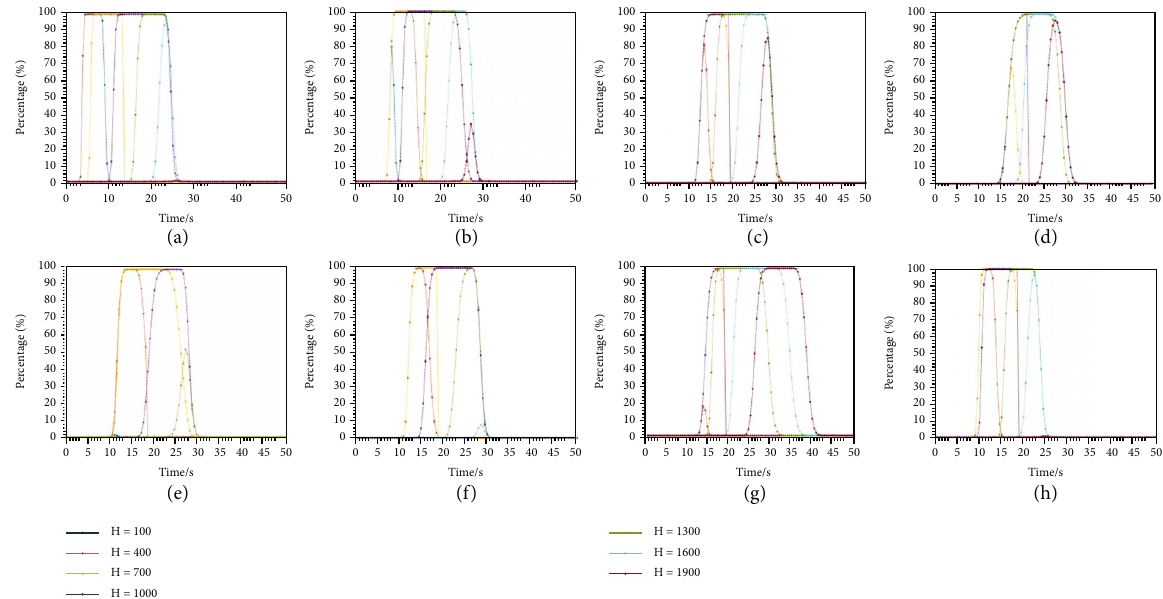
Figure 13: Con fl ict risk assessment of MAV constant airspeed climb and UAV horizontal fl ight in midlevel airspace ( fl ight altitude 1000- 4200 m ) versus H ∈ ½ 100, 1900 (cid:2) , θ = 0 , V = 610 Km/h , and V = 224Km/h . Results are averaged over 1000 simulations. Unbolded 3 UAV MAV UAV curves in the illustration indicate con fl ict probability < 10 ð − 7 Þ . (a) d = 2 × 10 3 , θ = 20 π /180 , θ = π /3 ; (b) d = 2 : 5 × 10 3 , θ = 20 π /180 , 3 MAV 3 MAV θ = π /3 ; (c) d = 3 × 10 3 , θ = 20 π /180 , θ = π /3 ; (d) d = 3 : 5 × 10 3 , θ = 20 π /180 , θ = π /3 ; (e) d = 3 × 10 3 , θ = 13 π /180 , θ = π /3 ; (f) 3 MAV 3 MAV 3 MAV d = 3 × 10 3 , θ = 15 π /180 , θ = π /3 ; (g) d = 3 × 10 3 , θ = 20 π /180 , θ = π /6 ; (h) d = 3 × 10 3 , θ = 20 π /180 , θ = π /2 3 MAV 3 MAV 3 MAV